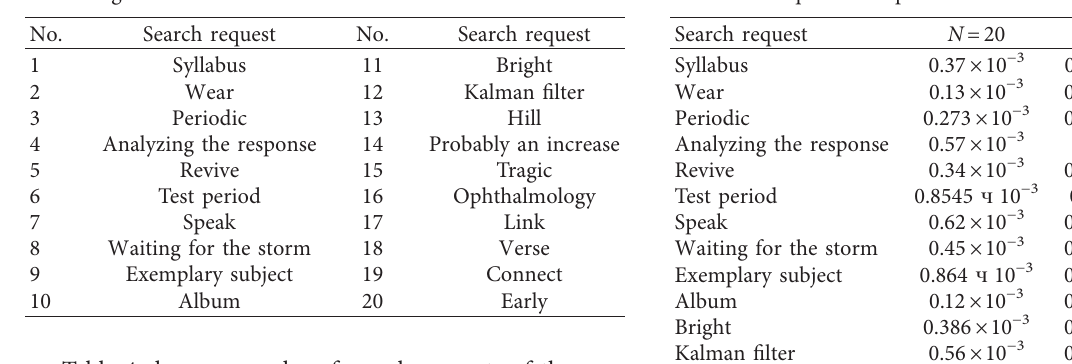
Table 5: Time of ranking operation ( s ) depending on the sample size in the sequential implementation of the block.